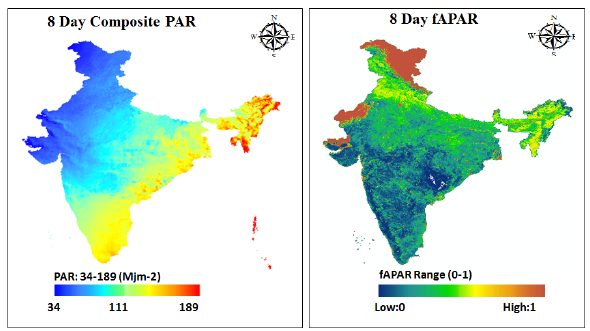
Figure 7: 8 Day Composite PAR & fAPAR map of India during 13-20Aug, 2018